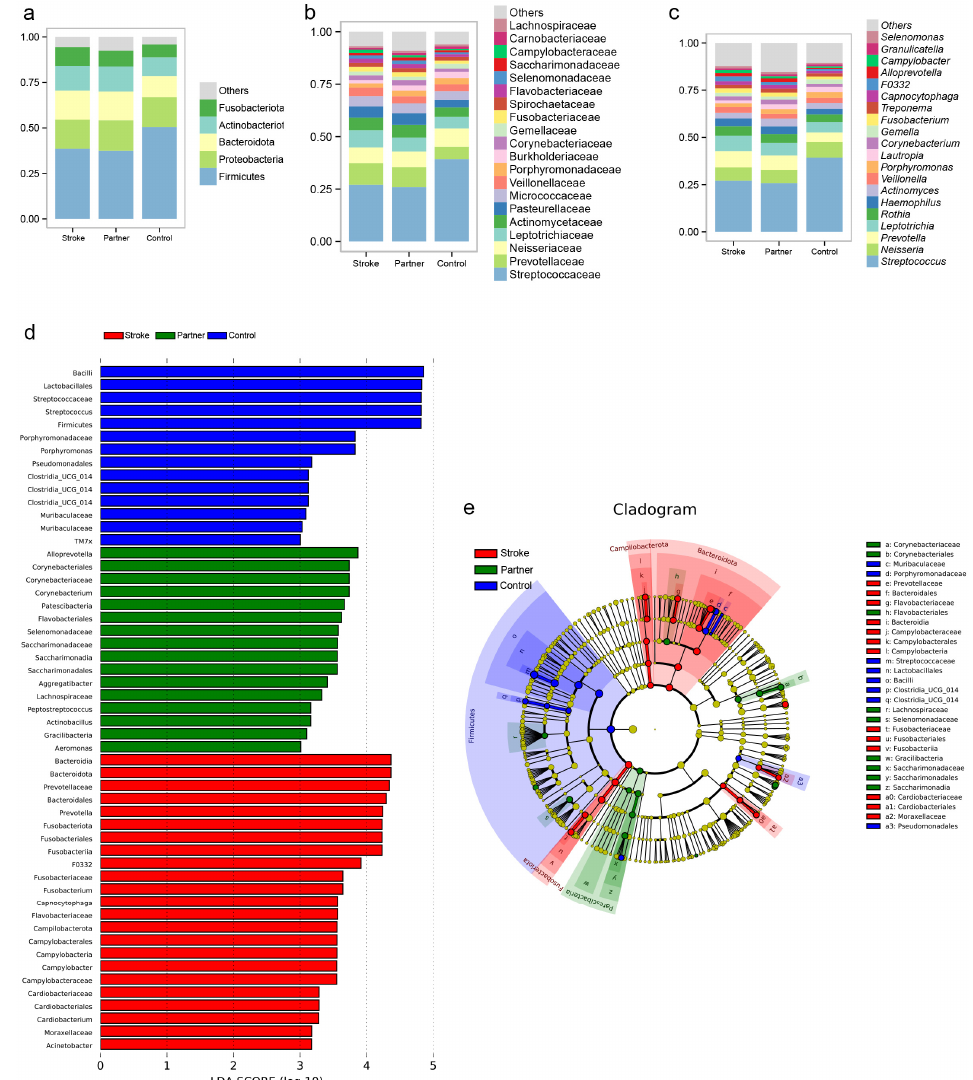
Figure 3. The oral microbiota composition and the significantly different taxa identified by LEfSe analysis among groups. ( a – c ) Stacked bar plot representing the relative abundances of microbiota at phylum, family, and genus levels, respectively. ( d ) A histogram of the linear discriminant analysis (LDA) plot performed by LefSe analysis shows distinct oral microbiome composition between the three groups. Red indicates enriched taxa in poststroke patients, green indicates the taxa enriched in partners of poststroke patients and blue indicates taxa enriched in the control group. ( e ) A cladogram for taxonomic representation performed by LefSe analysis showing distinct bacterial taxa between the three groups. As an algorithm for high-dimensional biomarker discovery, LEfSe identifies genomic features that characterize differences between two or more biological conditions. By emphasizing statistical significance, biological consistency, and effect relevance, LEfSe determines the abundant feature with the greatest difference between conditions in accordance with biologically meaningful categories. For each differential feature detected using LEfSe, a linear discriminant analysis value was calculated, representing the difference in the feature between groups. Only taxas with LDA scores above ± 3.0 are